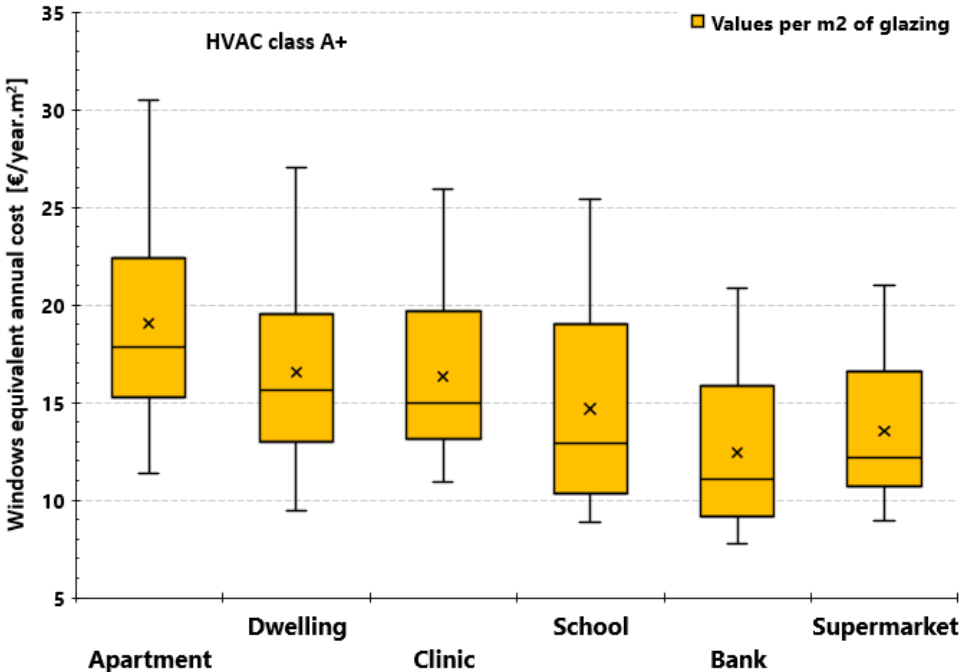
Figure 4. Comparison of windows equivalent annual cost ( EAC W ) for all building typologies (values per m 2 of glazed area of external envelope). Values for each building include all climate zones and all windows type.